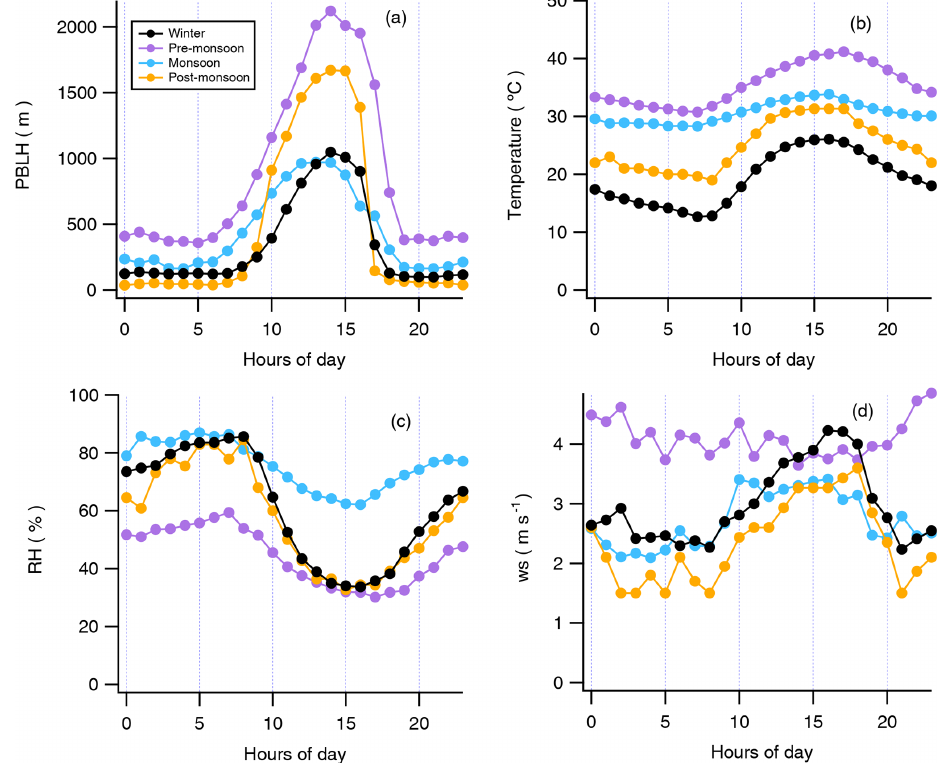
Figure 1. Box plots with (a) planetary boundary layer height (PBLH), (b) temperature, (c) relative humidity and (d) wind speed for the different seasons. The marker represents the mean.